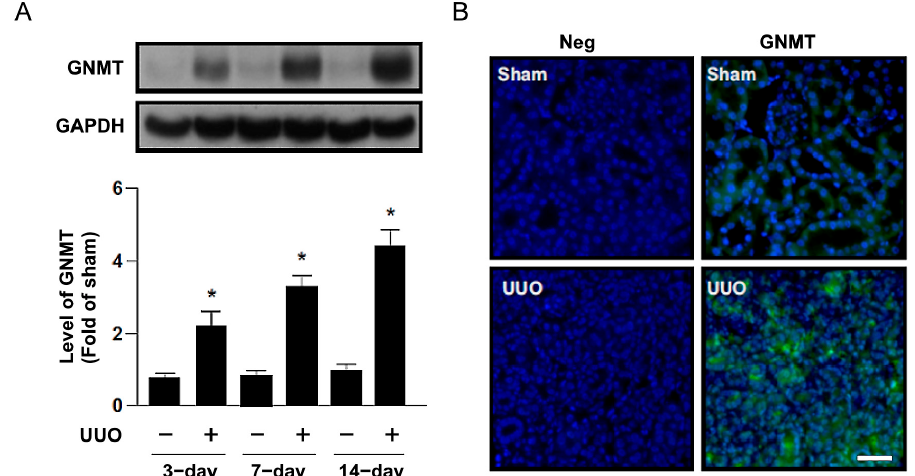
Figure 2. UUO upregulated GNMT expression in wild-type mice. ( A ) GNMT level in WT mice 3, 7 and 14 days after undergoing UUO surgery. The protein level of GNMT was analyzed by Western blotting. GAPDH was used as a loading control. ( B ) WT mice were observed for 14 days after undergoing UUO surgery. The protein expression of GNMT was measured by immunofluorescence. Neg: negative control. Magnification: 200 × . Scale bar: 50 µ m. The data are presented as means ± standard errors. * p < 0.05 versus the sham group.